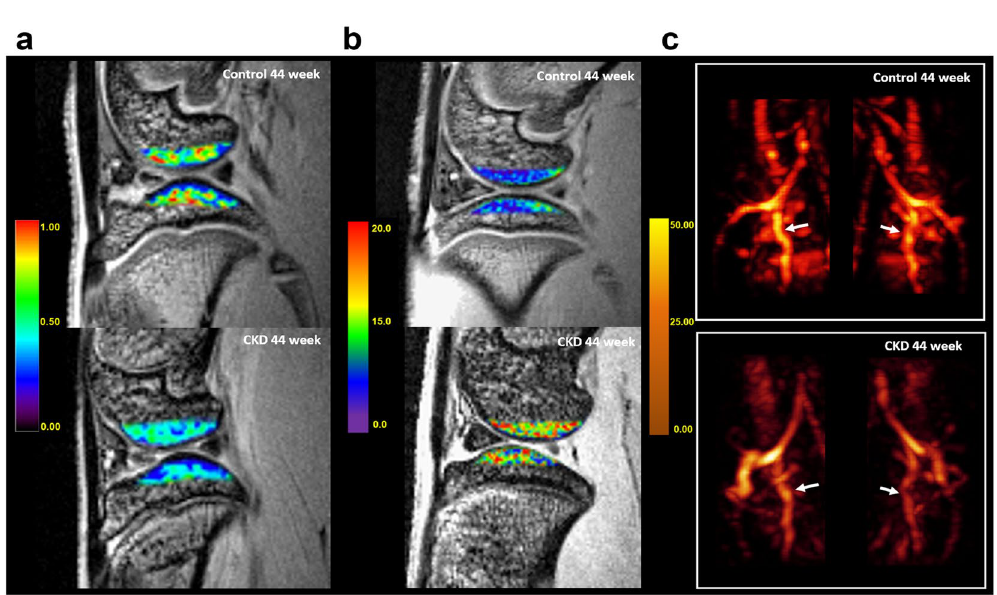
Figure 2. Representative DCE-MRI, MRI T2 * , and CE-MRA images. Exactly 44 weeks without intervention (control rats) or after 5/6 nephrectomy (CKD rats): ( a ) DCE images (amplitude A map) of the lateral femoral and tibial subchondral bone marrow of the right knee show significant hypoperfusion in the CKD group (lower) but not in the control group (upper); ( b ) MRI T2 * maps of the lateral femoral and tibial subchondral bone marrow of the right knee show significantly elevated T2 * values in the CKD group (lower) but not in the control group (upper); and ( c ) coronal maximum intensity projections (MIPs) of the CE-MRA images of popliteal arteries show a significantly lower signal intensity and smaller vessel diameters in the CKD group (lower). White arrows indicate the popliteal